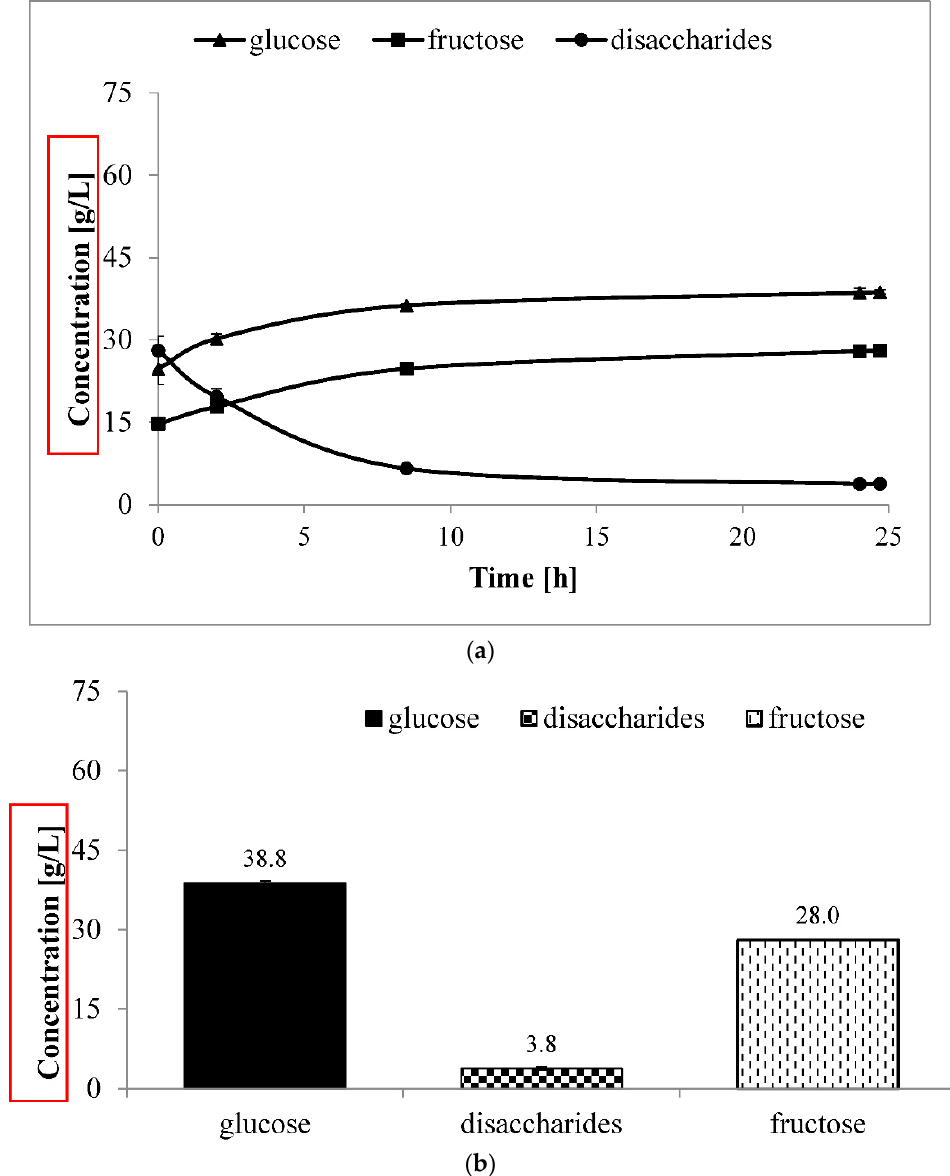
Figure 2. ( a ) Sugar types and content (g/L) as a function of enzymatic hydrolysis time of carob biomass (30% DM) used for LA production during enzymatic hydrolysis using two different 35 L pilot scales. Each data point is the mean ± SD. ( b ) Sugar types and final content (g/L) of carob bagasse (30% DM) were used for LA production during enzymatic hydrolysis using two different 35 L pilot scales. Each bar is the mean ±